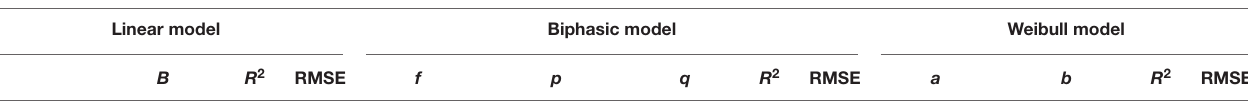
TABLE 2 | The fitted parameters of linear model, biphasic model, and Weibull